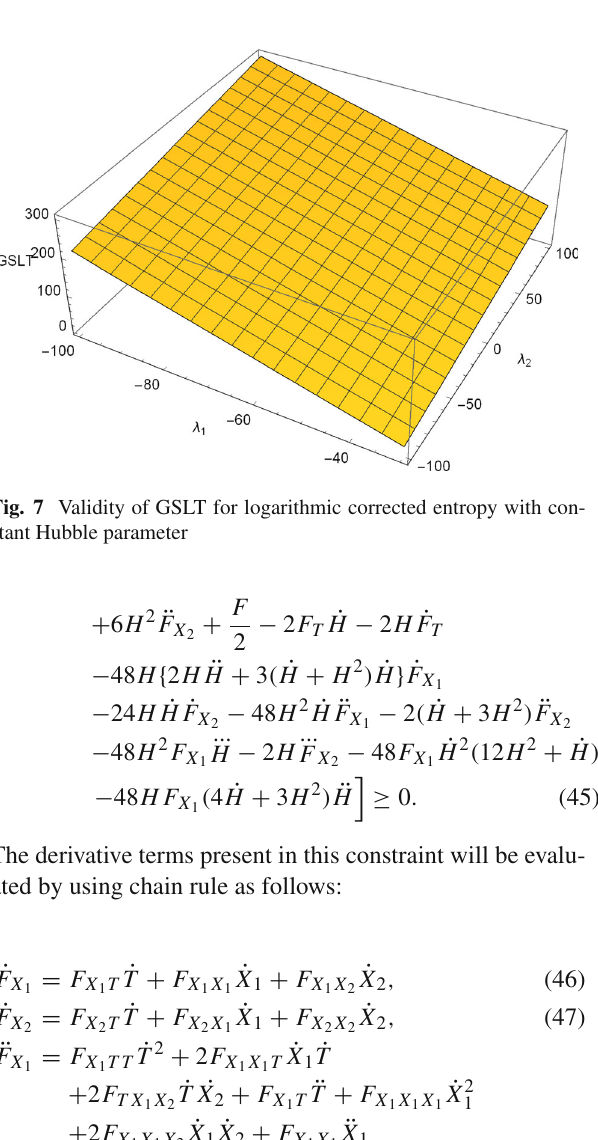
Fig. 6 Left plot represents the regions where GSLT is satisfied for β 3 = 0 in intermediate case and right graph corresponds to evolution of GSLT versus β 3 = − 2. Herein, we set b 1 = 2, σ = 2 and β = 0 . 5